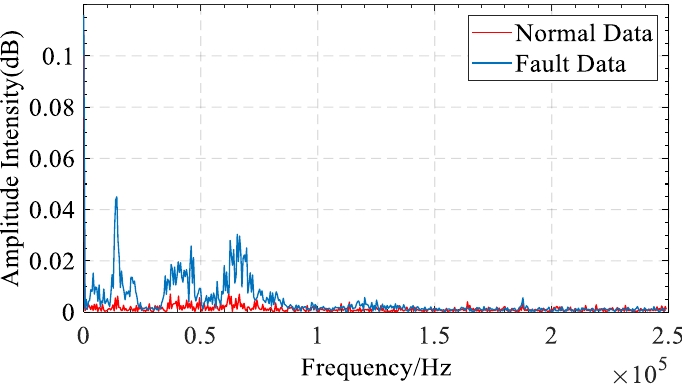
Figure 7. Comparison of current waveforms in the frequency domain.